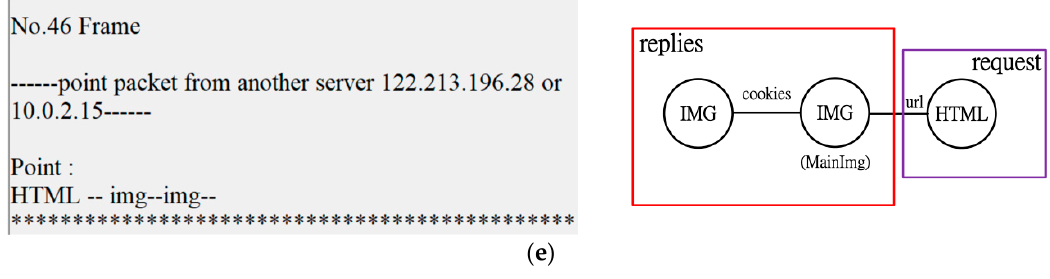
Figure 5. Ad libs’ network behaviors and their graph representations ( a ) MoPub, ( b ) Mmate, ( c ) Hap-game, ( d ) Millennial Media, ( e ) AppLovin.